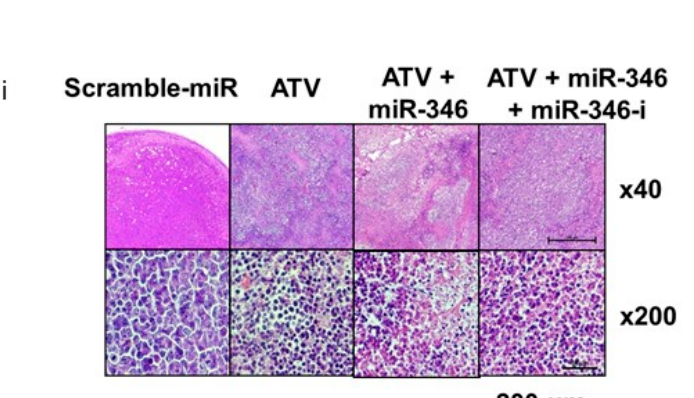
Figure 5. Target relationship between miR-346 and HIF-1a in Raji cells. ( a ) The cell lysates were immunoblotted with the indicated antibodies after miR-346 inhibitor treatment (* p < 0.05). ( b ) Cells were treated with ATV and miR-346 inhibitor for 24 h, and ELISA was performed to quantify the level of HIF-1 α transcription activity. ( c ) Representative images of Raji tumor-bearing mice after injection of each treatment. ( d ) In vivo tumor growth delay of Raji xenografts intratumorally-treated with ATV, ATV+miR-346, ATV+miR-346+miR-346 inhibitor. ( e ) Tumors were excised and weighed at the end of the experiment. (* p < 0.05; ** p < 0.01). ( f ) Western blots of cleaved PARP protein levels in Raji xenografts. ( g) HIF-1 α immunohistochemical stain levels in mice receiving each treatment and corresponding result of IHC scoring. ( h ) Representative images of tumors isolated from each treated mice, n = 4. ( i ) Hematoxylin and eosin (H&E) staining was examined by immunohistochemistry.